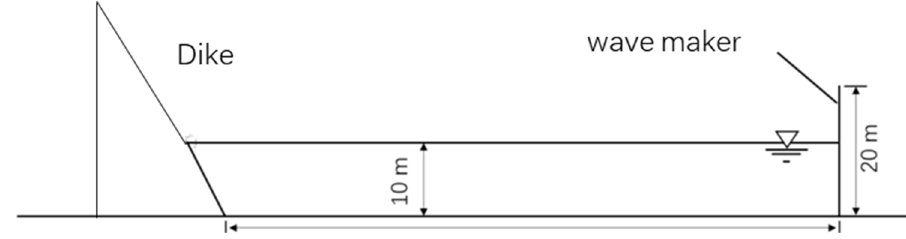
Figure 7. Initial setup of the SPH flume of Dazuo Seawall .